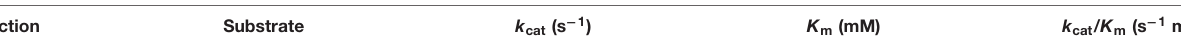
TABLE 4 | Kinetic parameters of racemase and β -lyase reactions.